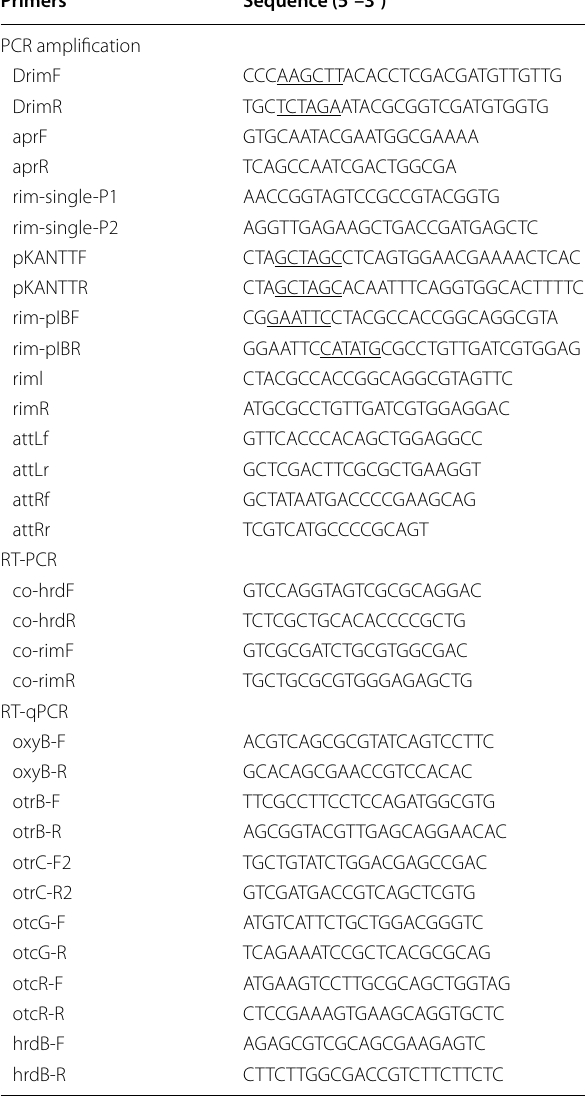
Restriction sites are underlined